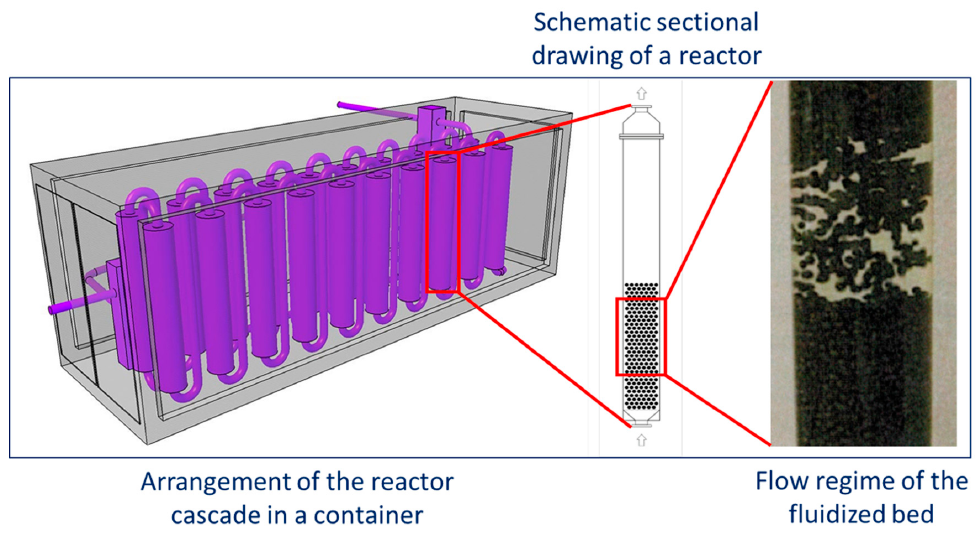
Figure 1. Scheme of the fluidized bed reactor (FBR).